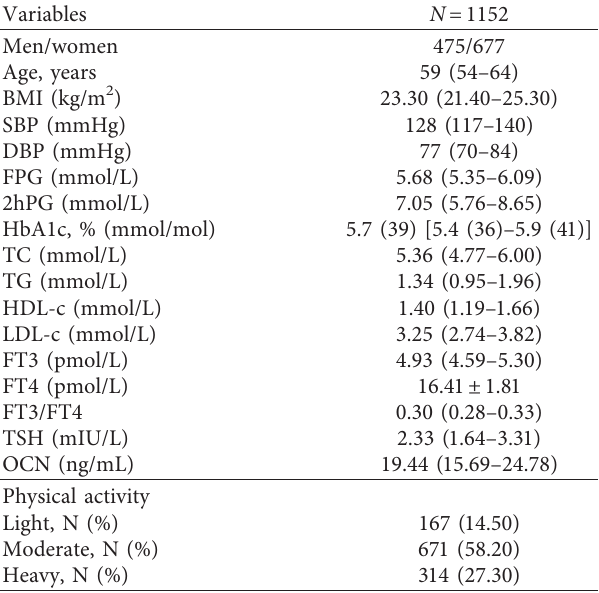
Table 1: Clinical characteristics of subjects.